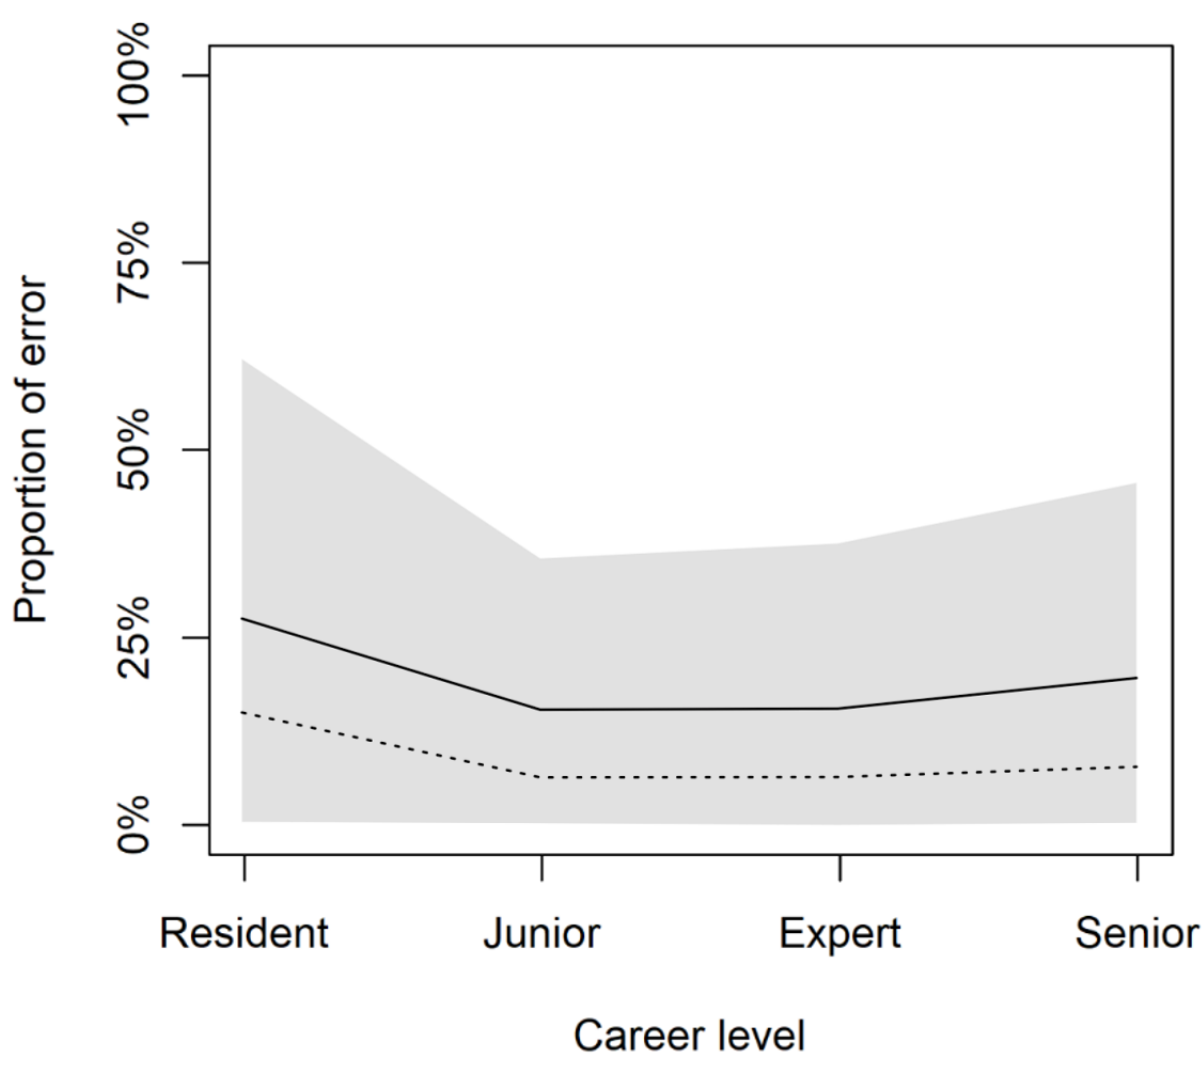
Figure 3. Prediction of average pathologist performance. Pathologists of intermediate levels of career perform better on average. The graph depicts the posterior predictive distributions for the multilevel model. Solid lines represent posterior mean values; shaded regions represent 89% high-posterior density interval; and dashed lines represent raw